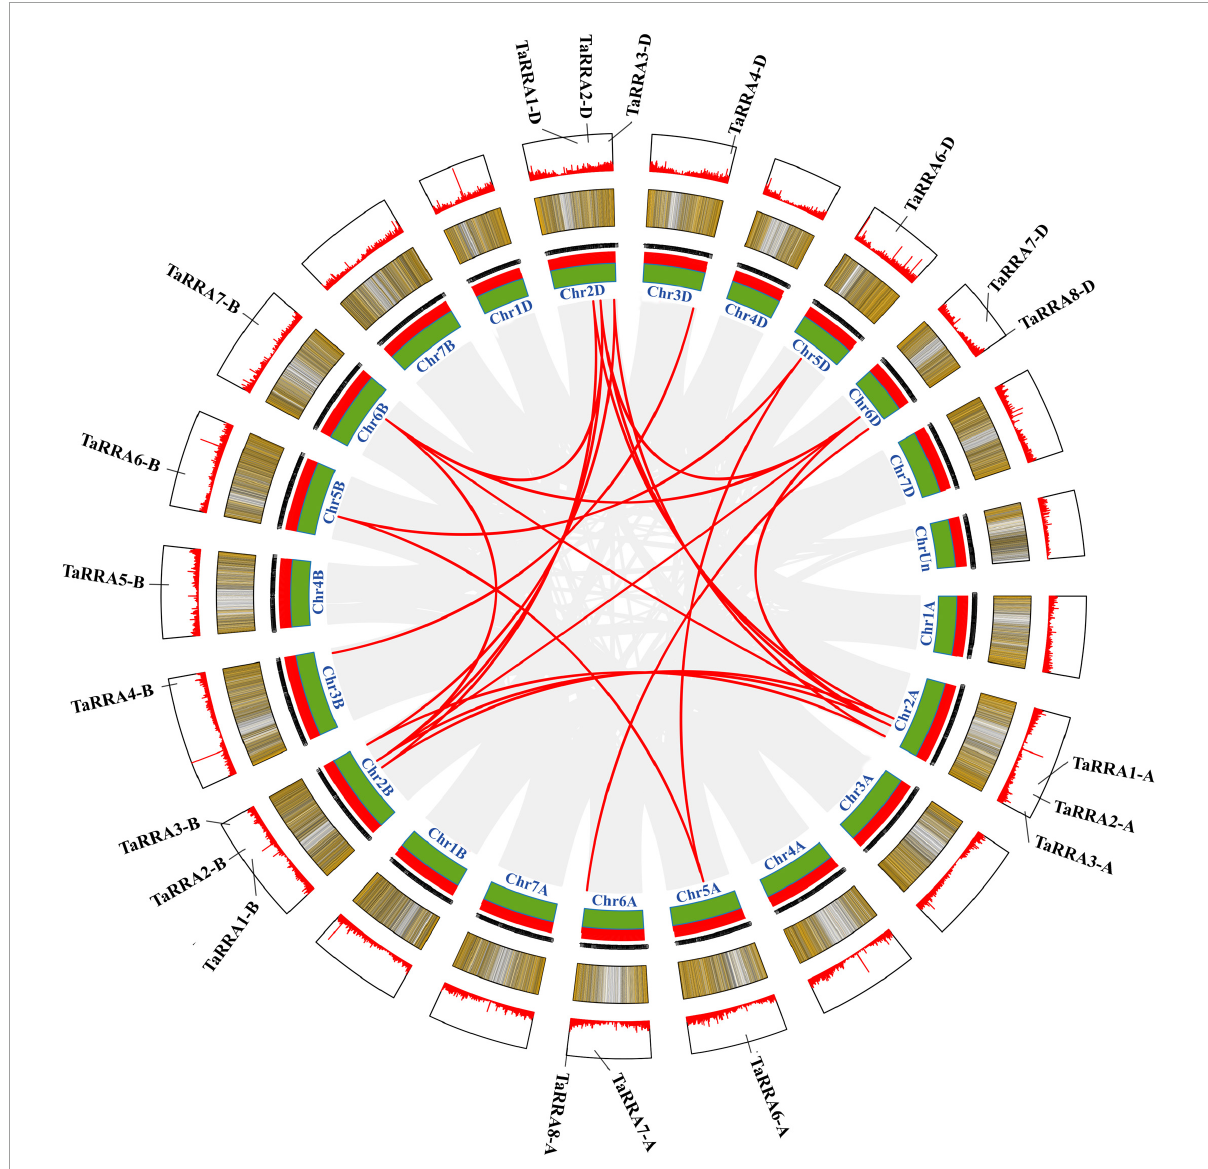
FIGURE3 Schematic diagram of the inter-chromosomal relationships of TaRRA genes. Gray lines indicate all syntenic blocks in the wheat genome, and red lines indicate the presence of TaRRA genes.